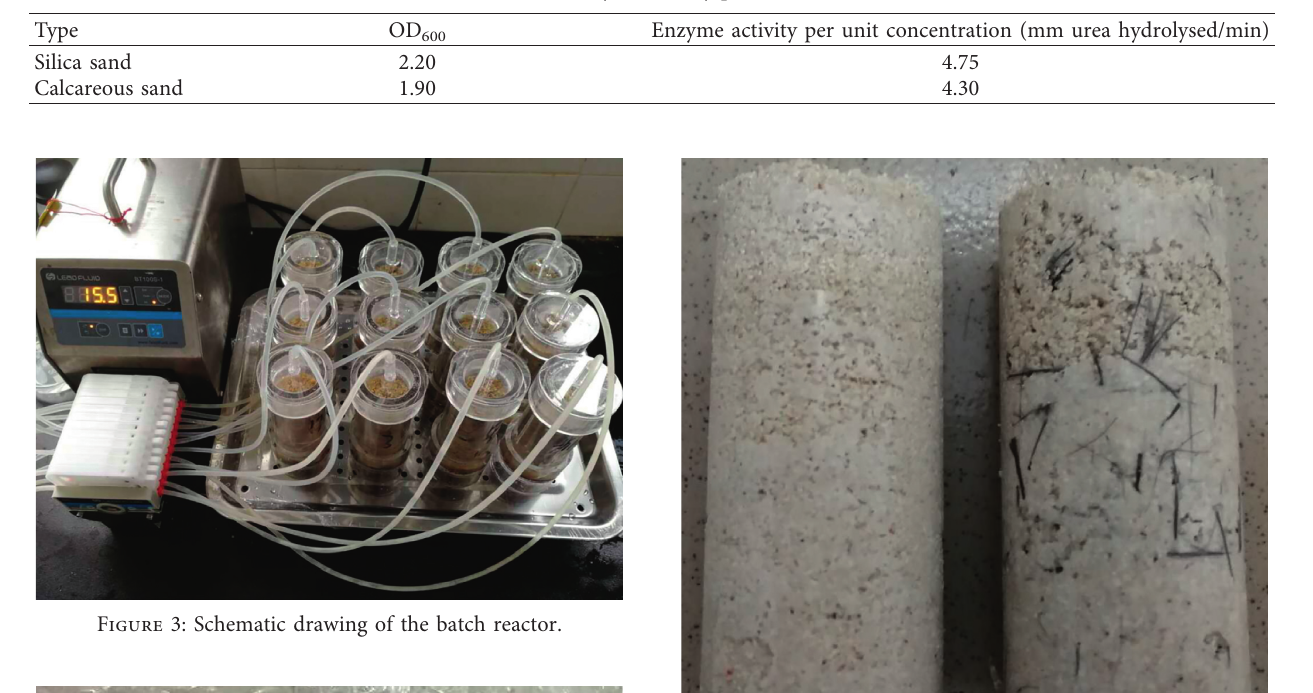
Table 3: OD600 and enzyme activity per unit concentration.